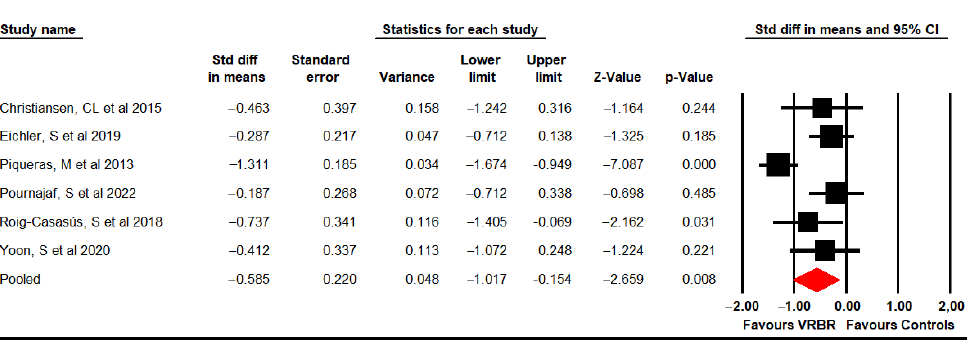
Figure 4. Forest plot of the immediate effect of VRBR on dynamic balance [59–62,68,69].